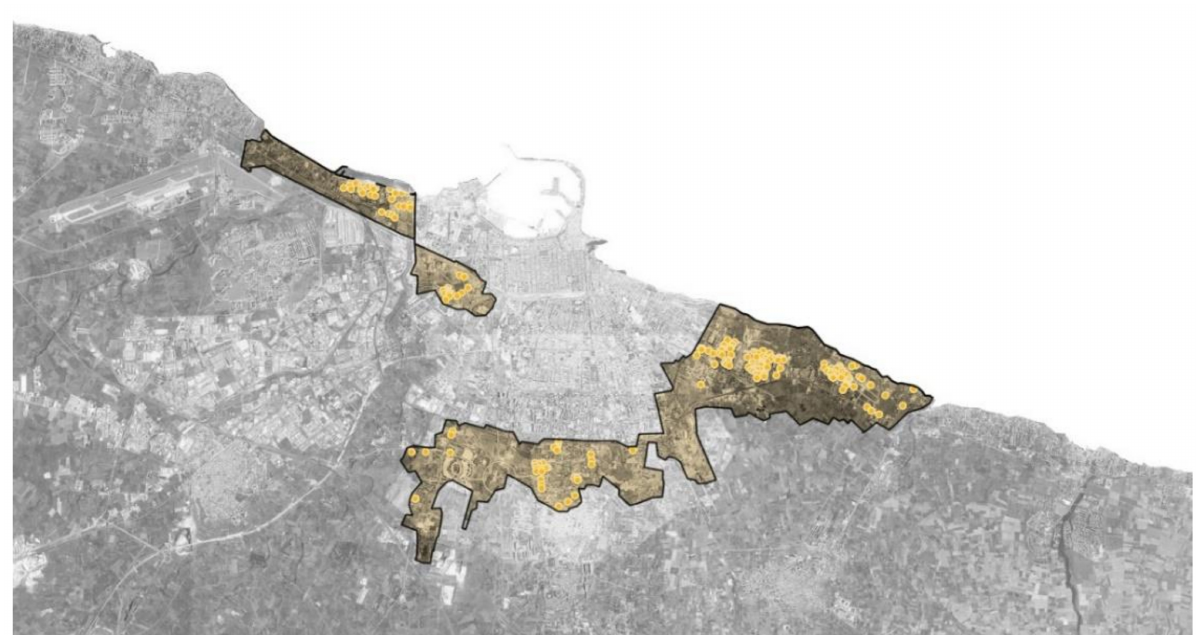
Figure 3. Localization of the study sample properties in the OMI peripheral area of the city of Bari.